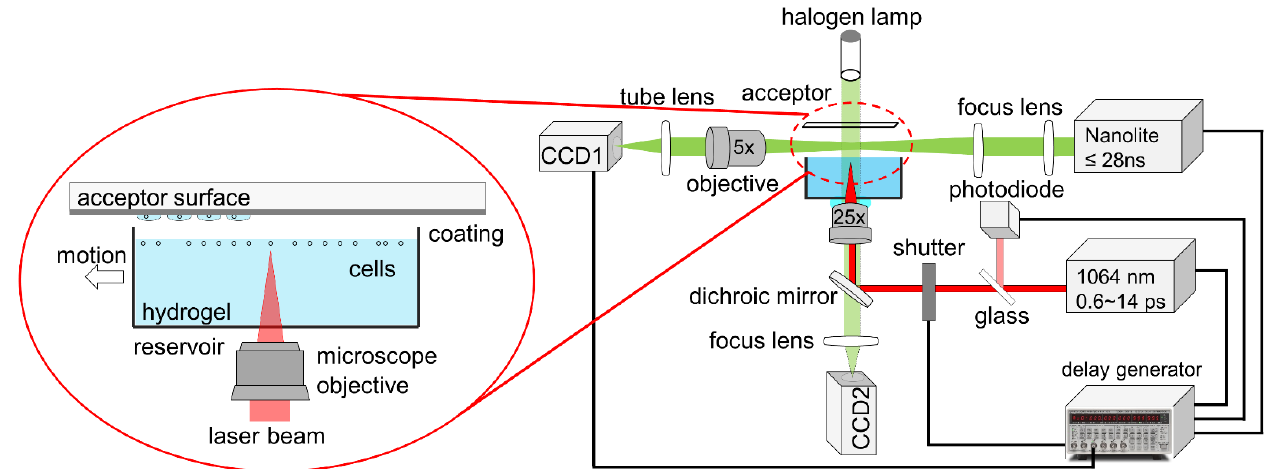
Figure 1. Time-resolved imaging system for visualizing the printing process including cavitation bubble expansion and subsequent jet propagation. The laser beam was focused into the hydrogel by using a water immersion microscope objective. The transfer process was illuminated with a ns white-light pulse and then captured with an imaging system.